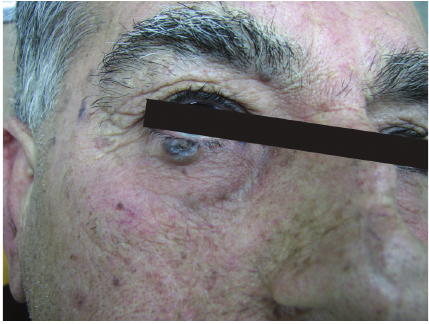
Figure 1: A man with 2 BCC lesions in lower lid.